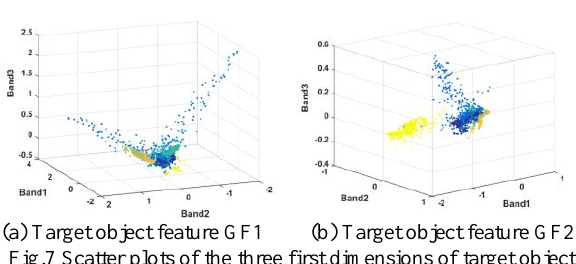
Fig.6 Scatter plots in original space (RGB bands) on 2 data sets.